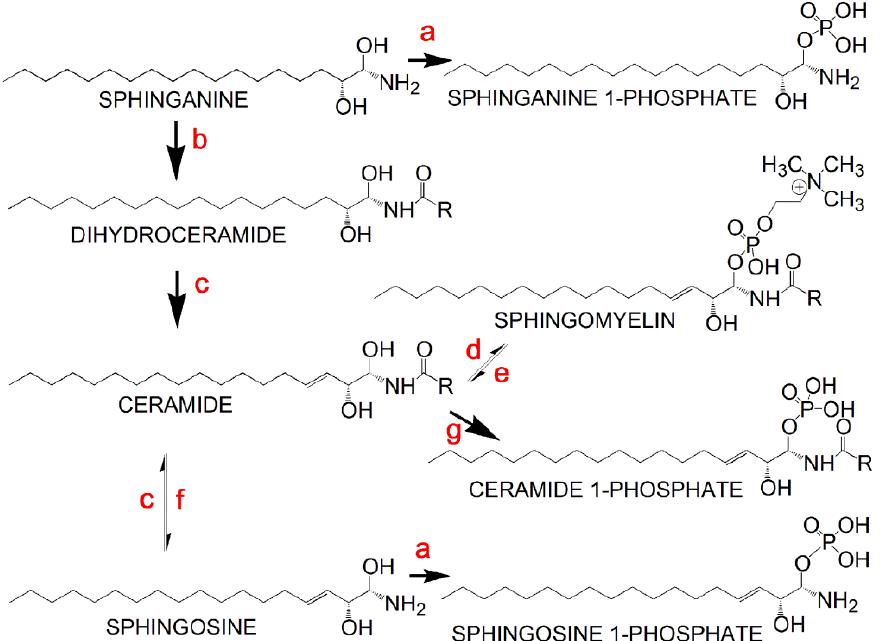
Figure 3. Metabolic interconversions of the principal sphingolipids: a, sphingosine kinase (EC 2.7.1.91); b, ceramide synthase (EC 2.3.1.299); c, dihydroceramide desaturase (EC 1.14.19.17); d, sphingomyelin synthase (EC 2.7.8.27); e, sphingomyelin phosphodiesterase (EC 3.1.4.12); f, ceramidase (EC 3.5.1.23); g, ceramide kinase (EC 2.7.1.138).